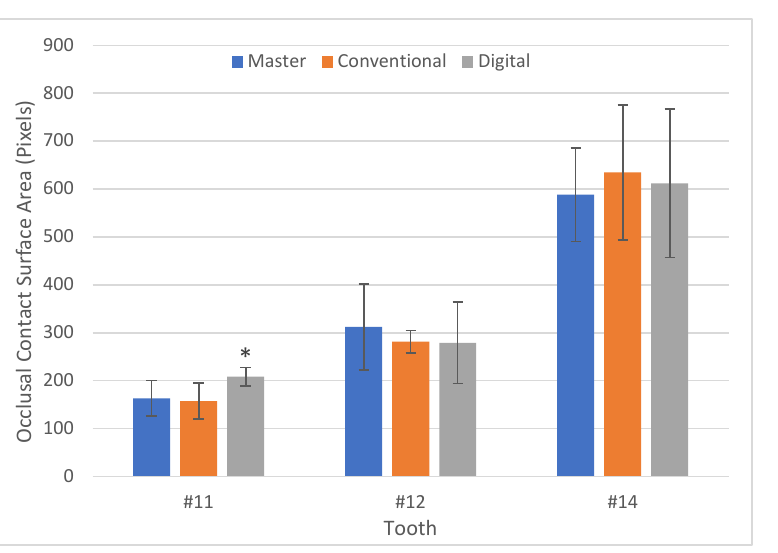
Table 1. Occlusal contact surface area (pixels) post image processing.